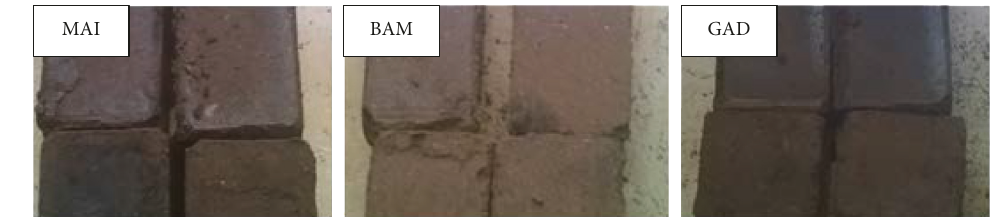
Figure 2: Compress the sample with a compaction pressure of 3MPa.